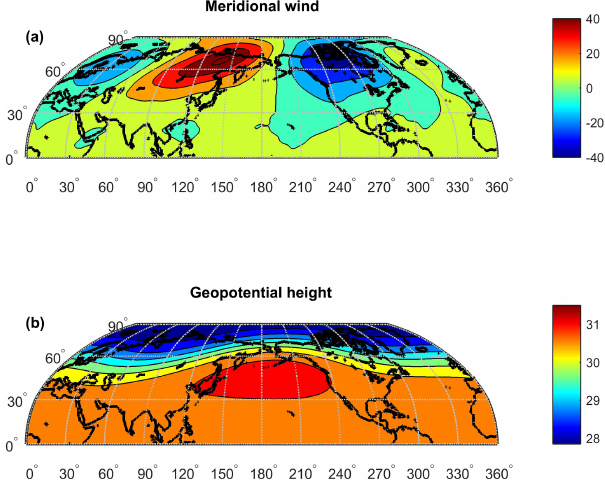
Figure 4. Meridional wind ( a ,ms − 1 ) and geopotential height ( b ,km) at 10hPa, January 1988. Horizontal axis, longitude; verti- cal axis,